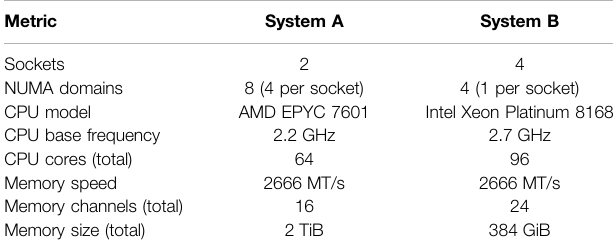
TABLE 5 | Speci fi cations of the two servers used for parallel performance